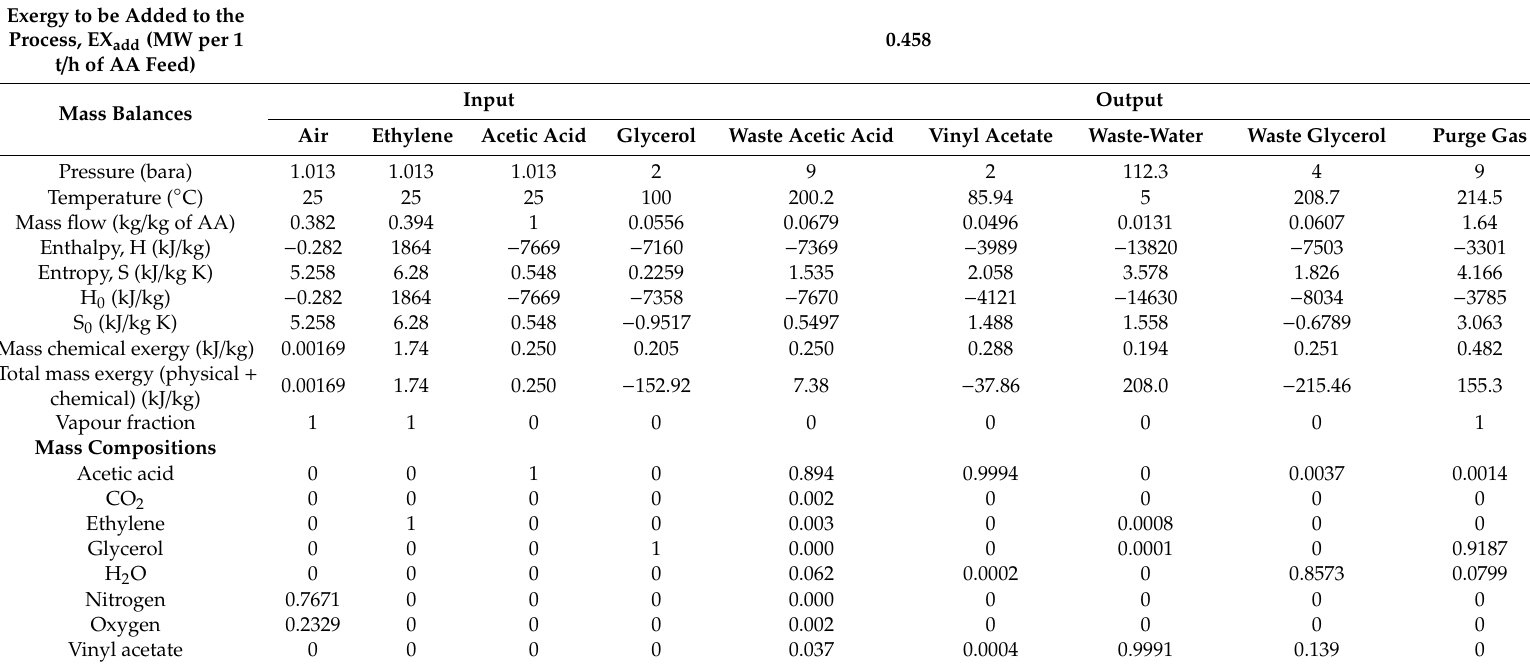
Table 2. Simulation results of vinyl acetate